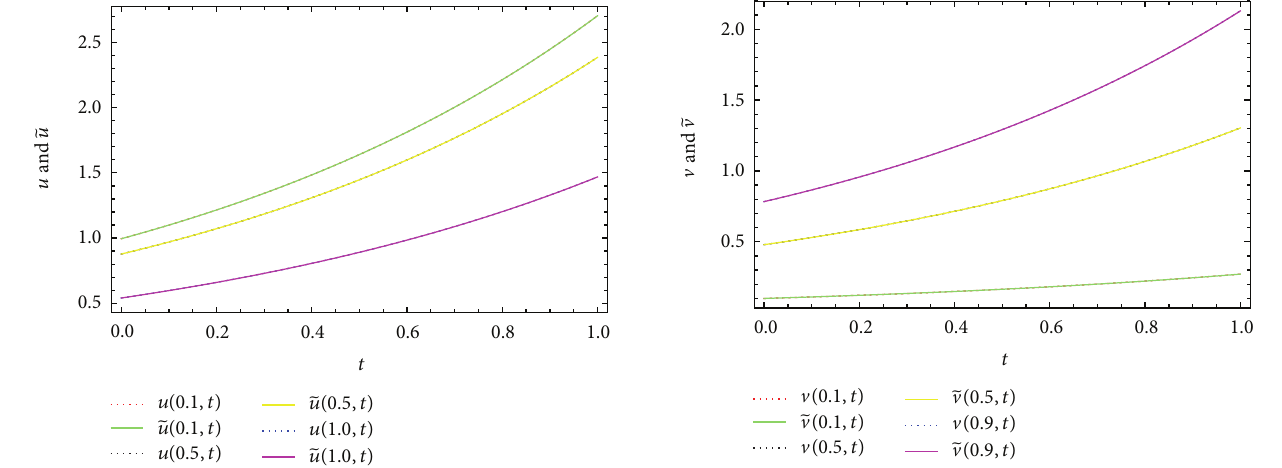
Figure 16: The approximate ̃𝑢 and the exact 𝑢 solutions for different values of 𝑦 = 0.1 , 0.5, and 1.0 of problem (55), where 𝑁 = 10 and 𝛼 = 𝛽 = 1/2 in the interval [0,1] .